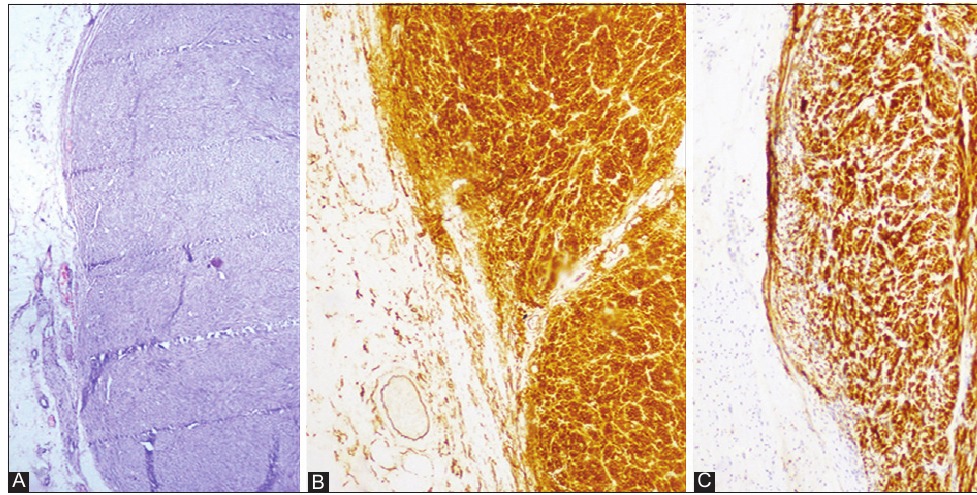
FIGURE 1. Well‑delineated spindle cell tumor was seen in hematoxylin‑eosin‑stained sections (A), immunohistochemically CD 34 posi‑ tivity (B) and DOG‑1 positivity (C) were also seen in the case having larger tumor